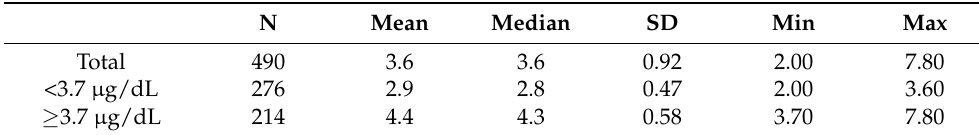
Table 1. Means, medians, standard deviations (SD) and range of blood lead levels ( µ g/dL) in the total sample of girls and in the two blood lead level groups. N Mean Median